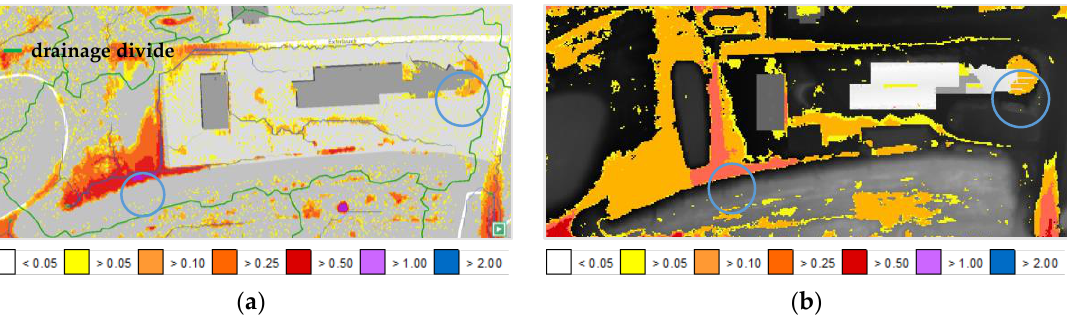
Figure 10. Predicted flood extent and depth after the rain event: ( a ) reference flood map [30]; ( b ) simulation using acceleration solver, and the DEM-base auto-generated roughness coefficient values on the height-corrected DEM.